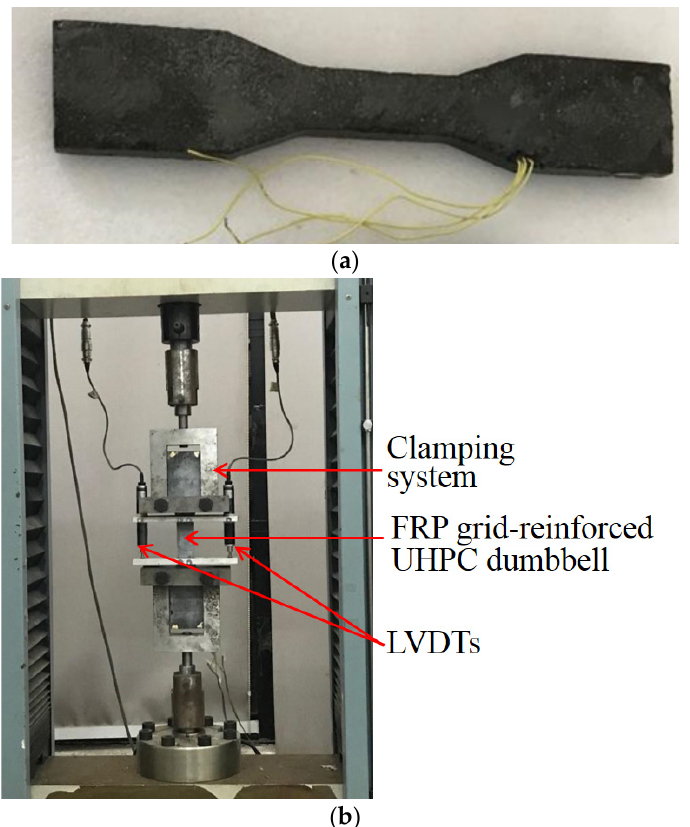
Figure 4. FRP grid-reinforced UHPC dumbbell and tensile test set-up. ( a ) FRP grid-reinforced UHPC dumbbell; ( b ) Tensile test set-up. Table 2. UHPC mix proportion (by